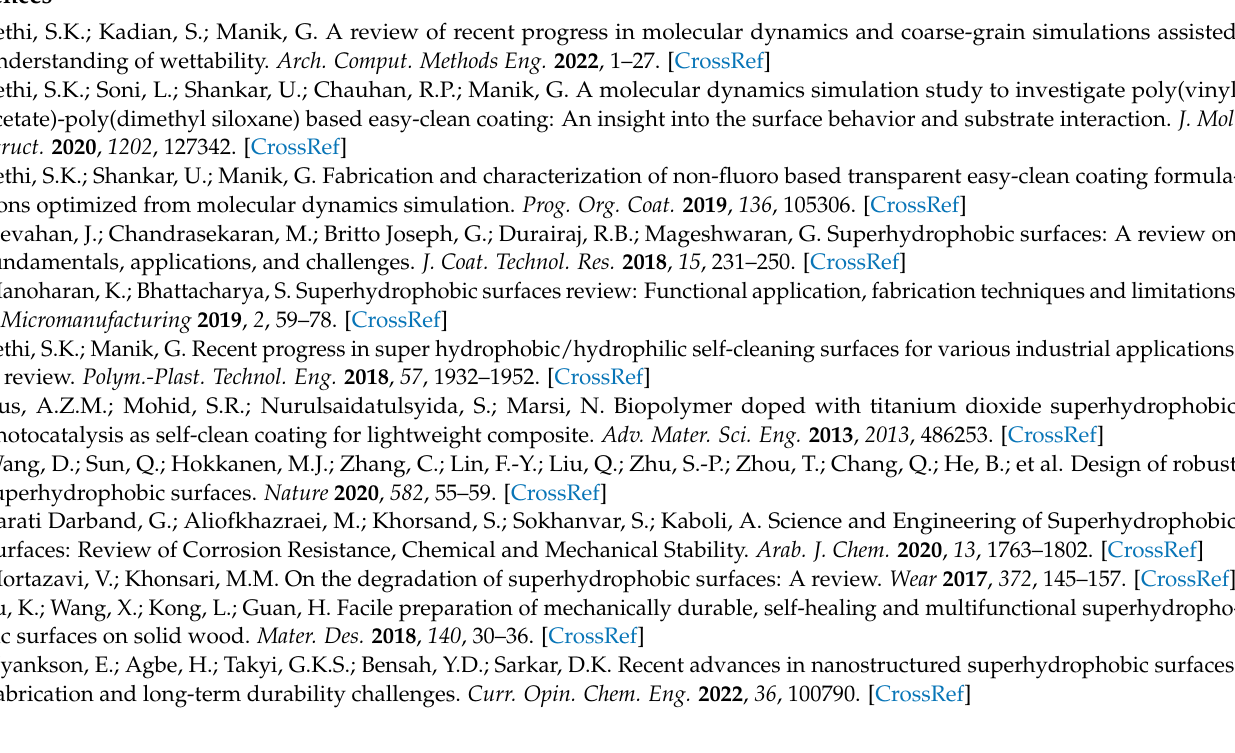
heights; Figure S2: The anti-icing setup for measuring the ice delay time (IDT), Table S1: Different methods to form hierarchical micro/nanostructured surfaces; Video S1: Sliding angle, Video S2: The whole process of water droplets (cid:48) transition from the liquid state to the ice state for the S and MN